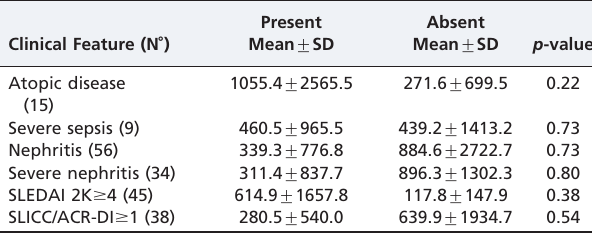
Table 2 - Total IgE serum concentrations (IU/ml) in 69 patients with juvenile systemic lupus erythematosus (JSLE) according to clinical features, disease activity and tissue